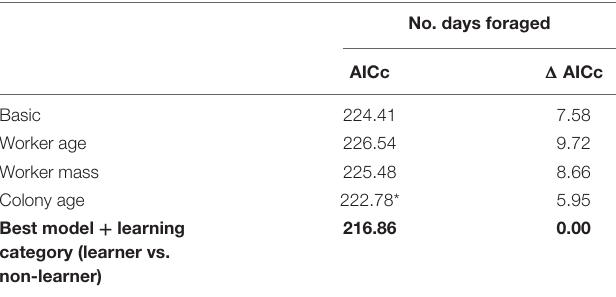
TABLE 4 | Candidate models to predict the number of days spent foraging by tested